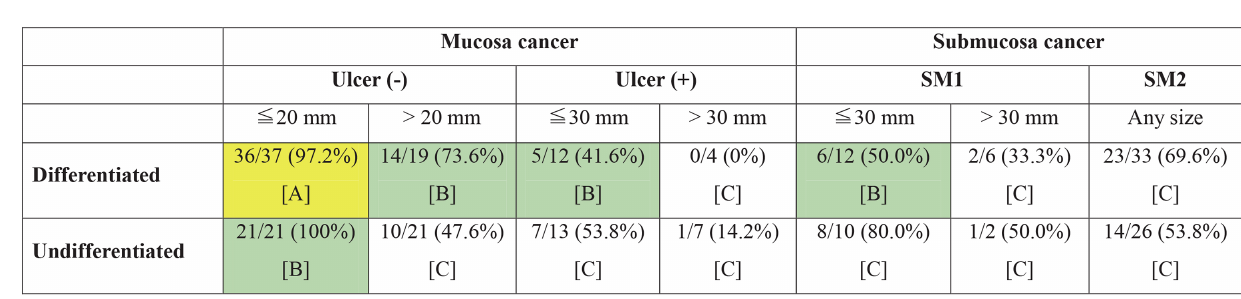
Figure 3. Accuracy of EUS according to the criteria of endoscopic resection. (A) Guideline criteria for EMR/ESD; (B) expanded criteria for EMR/ESD; (C) surgery. EUS, endoscopic ultrasonography; SM1, penetration into the submucosal layer < 500 µm from the muscularis mucosa; SM2, penetration over 500 µm; EMR, endoscopic mucosal resection; ESD, endoscopic submucosal